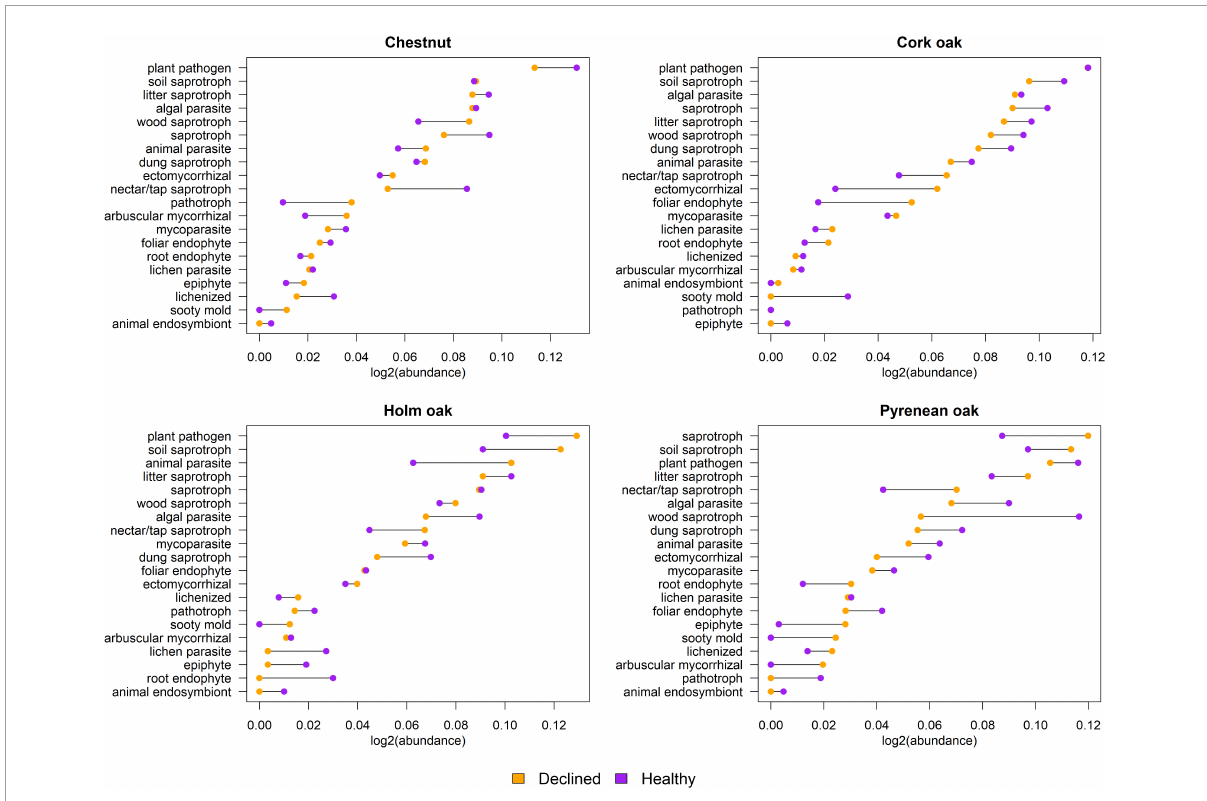
FIGURE8 Comparison of functional guilds between declined and healthy samples. Horizontal axis represents sum of abundances expressed as log 2 (guild abundance/total abundance). Connecting lines between two dots correspond to the difference between declined and healthy